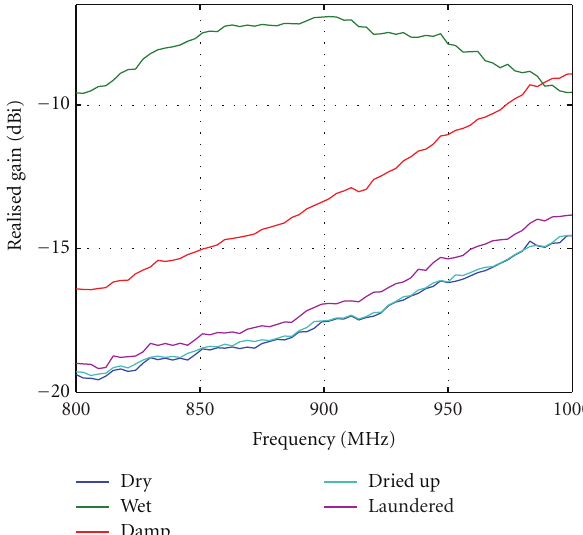
Figure 9: Frequency response of a tag with a broken t-match (Fabric (B), latex coating). When the tag is soaked, the matching section becomes conductive and the tag operates